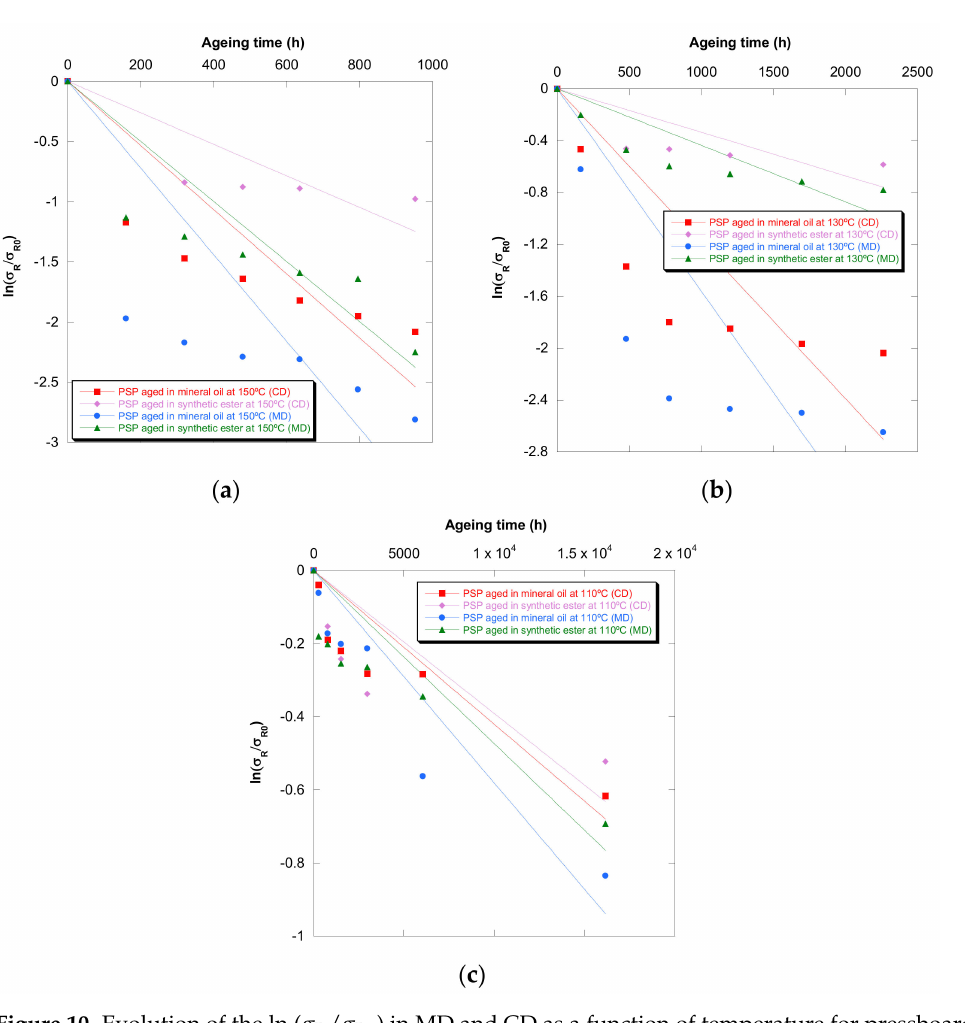
Figure 10. Evolution of the ln ( σ R / σ R0 ) in MD and CD as a function of temperature for pressboard PSP 3055 aged in mineral oil and in synthetic ester at 150 ◦ C ( a ), 130 ◦ C ( b ), and 110 ◦ C ( c ) and Weidmann’s